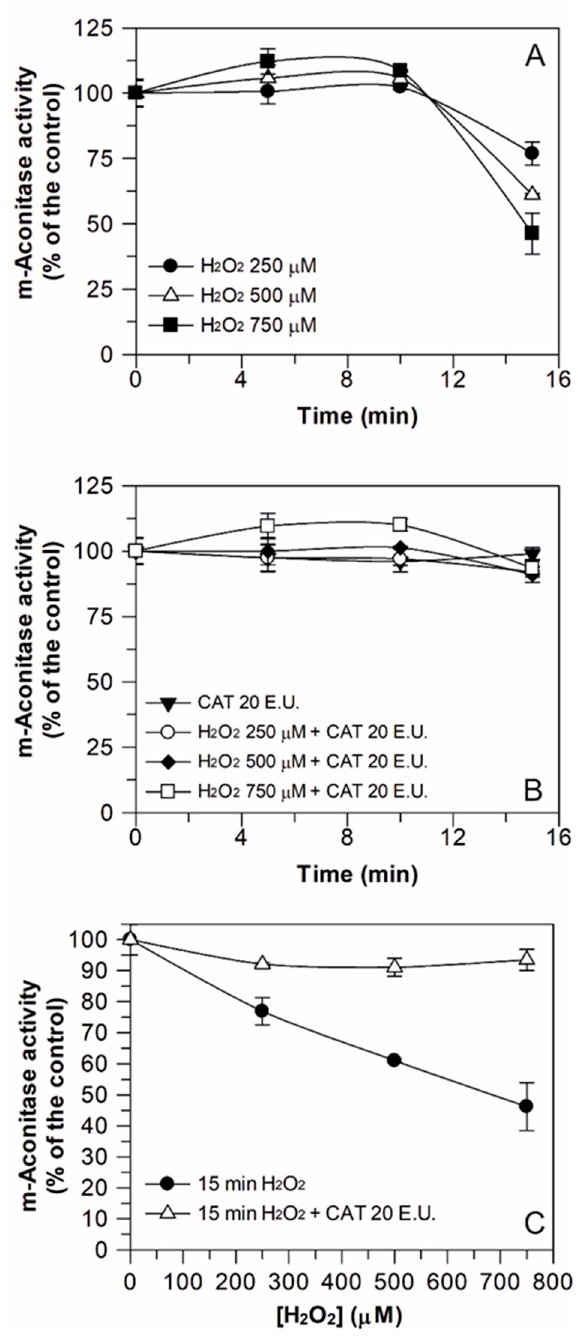
Figure 1. Effect of H 2 O 2 treatment on m-aconitase activity, evaluated in both the presence and absence of catalase. Measurements were carried out as described in Methods by incubating m-aconitase (250 µg) for different times (5, 10, and 15 min) in 100 mM Tris-HCl pH 8.0 buffer containing different H 2 O 2 concentrations (250, 500, and 750 µM), both in the absence and presence of 20 E.U. catalase (CAT). Activity values are reported as a percentage of the control (i.e., the reaction measured at time 0 in the absence of both H 2 O 2 and CAT) and represent the mean of three independent experiments ± SD. In ( A ) and ( B ), the dependence of m-aconitase activity on the incubation time is reported for each H 2 O 2 concentration tested in both the absence and presence of CAT, respectively. In ( C ), the effect of 15 min treatment of m-aconitase with di ff erent H 2 O 2 concentrations is shown, as evaluated in both the absence and presence of CAT. In this set of experiments, m-aconitase activity under control conditions was equal to 19 ± 1 (SD, n = 3) nmol · min − 1 · mg − 1 · of